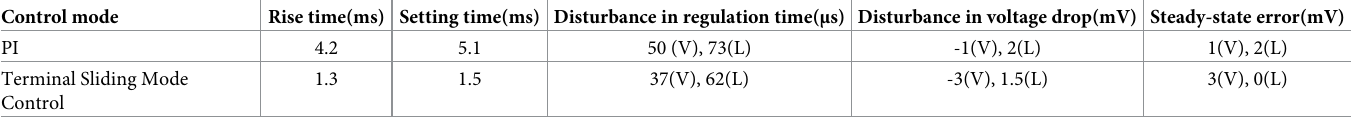
Table 2. Comparison between PI control and terminal sliding mode control in different disturbance